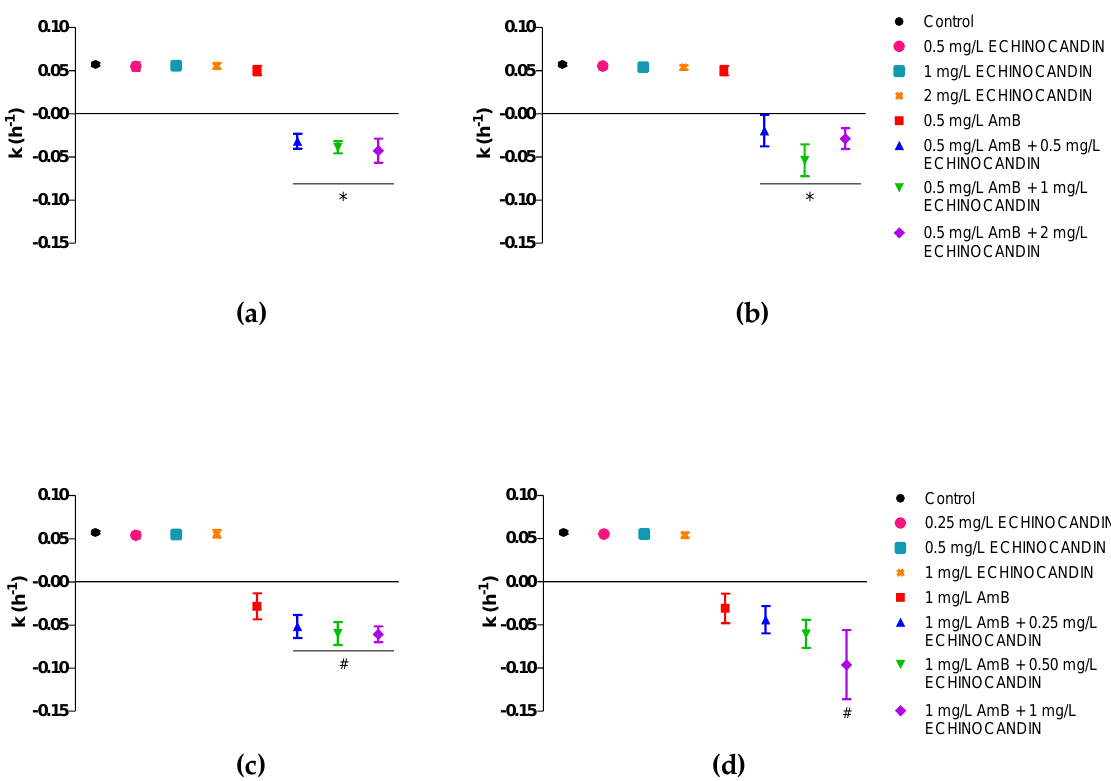
Figure 2. Mean killing-rate constant values for the combinations of amphotericin B and echinocandins against C. auris : ( a ) 0.5 mg/L of amphotericin B and anidulafungin; ( b ) 0.5 mg/L of amphotericin B and caspofungin; ( c ) 1 mg/L of amphotericin B and anidulafungin; ( d ) 1 mg/L of amphotericin B and caspofungin Each data point represents the mean result ± standard deviation (error bars) of all isolates and replicates. * p < 0.05 vs. 0.5 mg/L AmB; # p < 0.05 vs. 1 mg/L AmB (One-way ANOVA followed by Bonferroni’s post hoc test). AmB, amphotericin B.